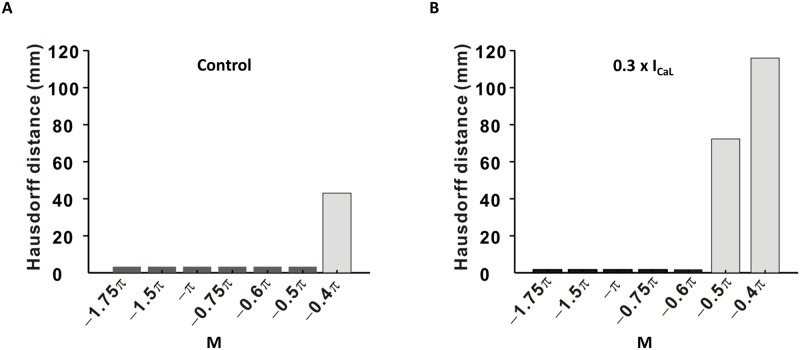
Quantitative comparison of spatial distributions in terms of the Hausdorff distance.Hausdorff distances between the results obtained by the location-centric method and the Iyer-Gray method were measured for different thresholds (M). (A) Hausdorff distances calculated for the control condition. (B) Hausdorff distances calculated for the 0.3 × ICaL condition.